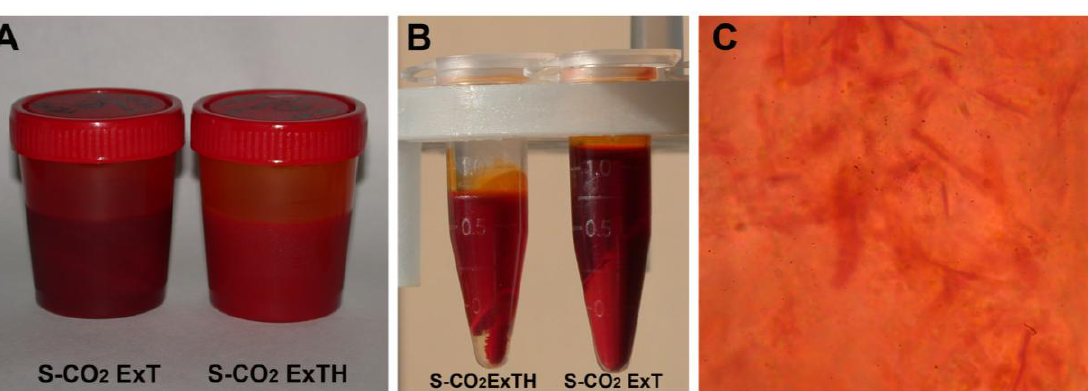
Figure 1. ( A ) Supercritical-CO -extracted oleoresins obtained from pure tomato powder 2 (S-CO ExT) and from tomato powder added with hazelnut powder (S-CO ExTH); 2 2 ( B ) oil- and insoluble fractions after centrifugation; ( C ) light microscope image of the crystal-like material scattered into the oil phase in the S-CO extracted oleoresins 2